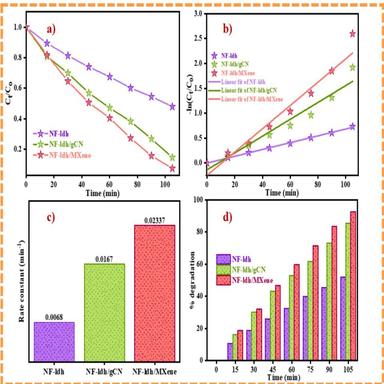
The kinetic representation of omeprazole (a) Ceq/Ct versus time, (b) – ln (Ceq/Ct) versus time, (c) the values of rate constant (k), and (d) percentage degradation.